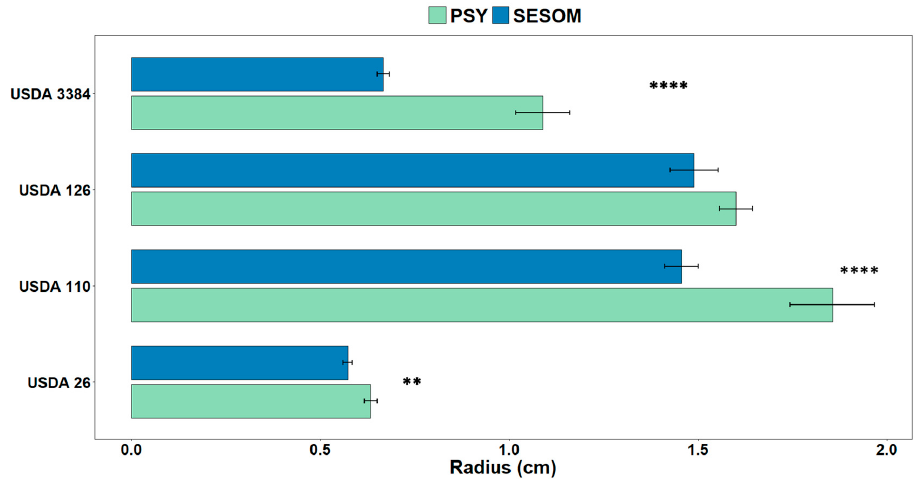
Figure 2. Motility radius of Bradyrhizobium strains spot-inoculated into either PSY-Arabinose or SESOM solidified with 0.35% agar and incubated for 10 d. Data were analyzed by Student t -test, and p values indicate statistical significance (ns not significant, ** p < 0.01, **** p <